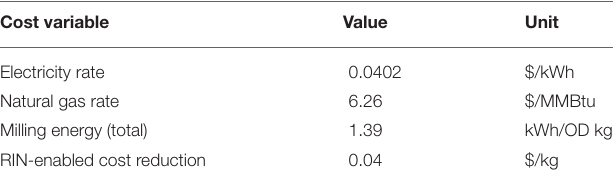
TABLE 6 | Variables used to calculate the optimized non-concentrated sugar cost.